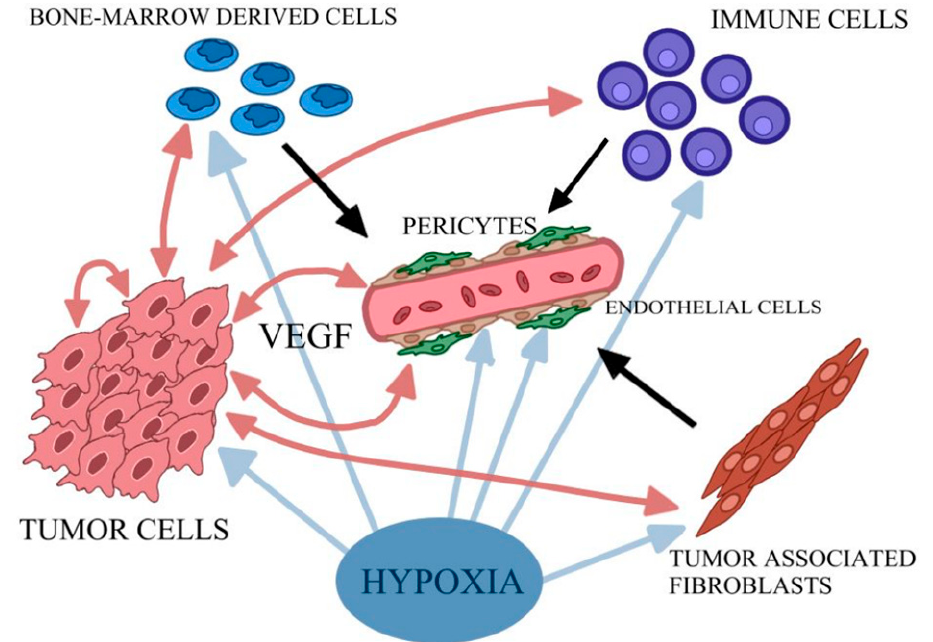
Figure 2. Simplified scheme of cascade of events triggered by hypoxia. Tumor cells produce VEGF and other pro-angiogenic factors, and a variety of pro-inflammatory cytokines stimulating endothelial cells to proliferate. Tumor-associated fibroblasts and bone-marrow-derived angiogenic cells additionally stimulate the endothelial cells. The creation of stable vessel interplay with pericytes is also needed. Own elaboration based on